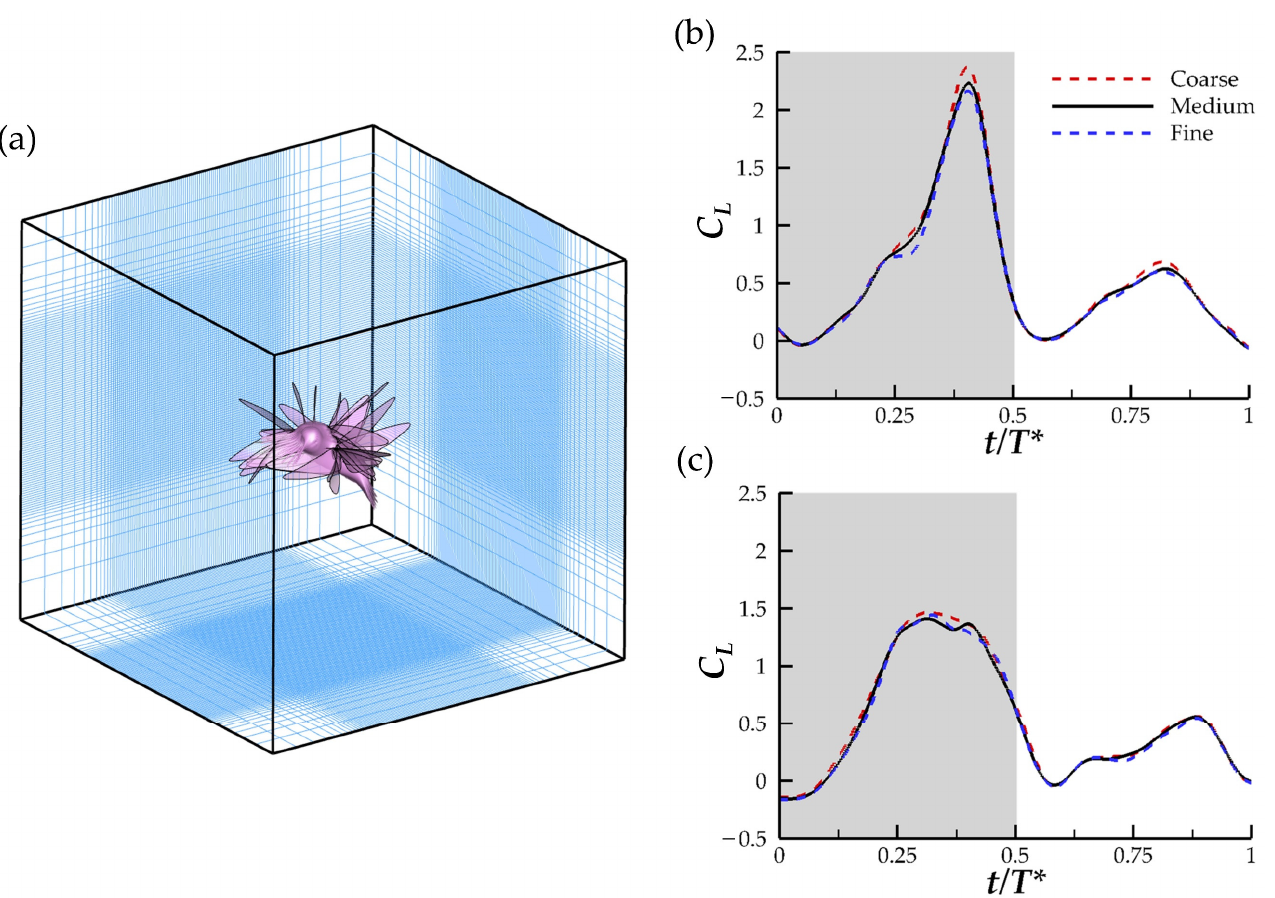
Figure 3. ( a ) Computational domain illustrating the orientation of the body in the fluid do- main, ( b ) comparison of the forces for the inner wing and ( c ) outer wing for the coarse mesh (~7.1 million grids), medium mesh (~11.2 million grids), and fine mesh (~17.0 million